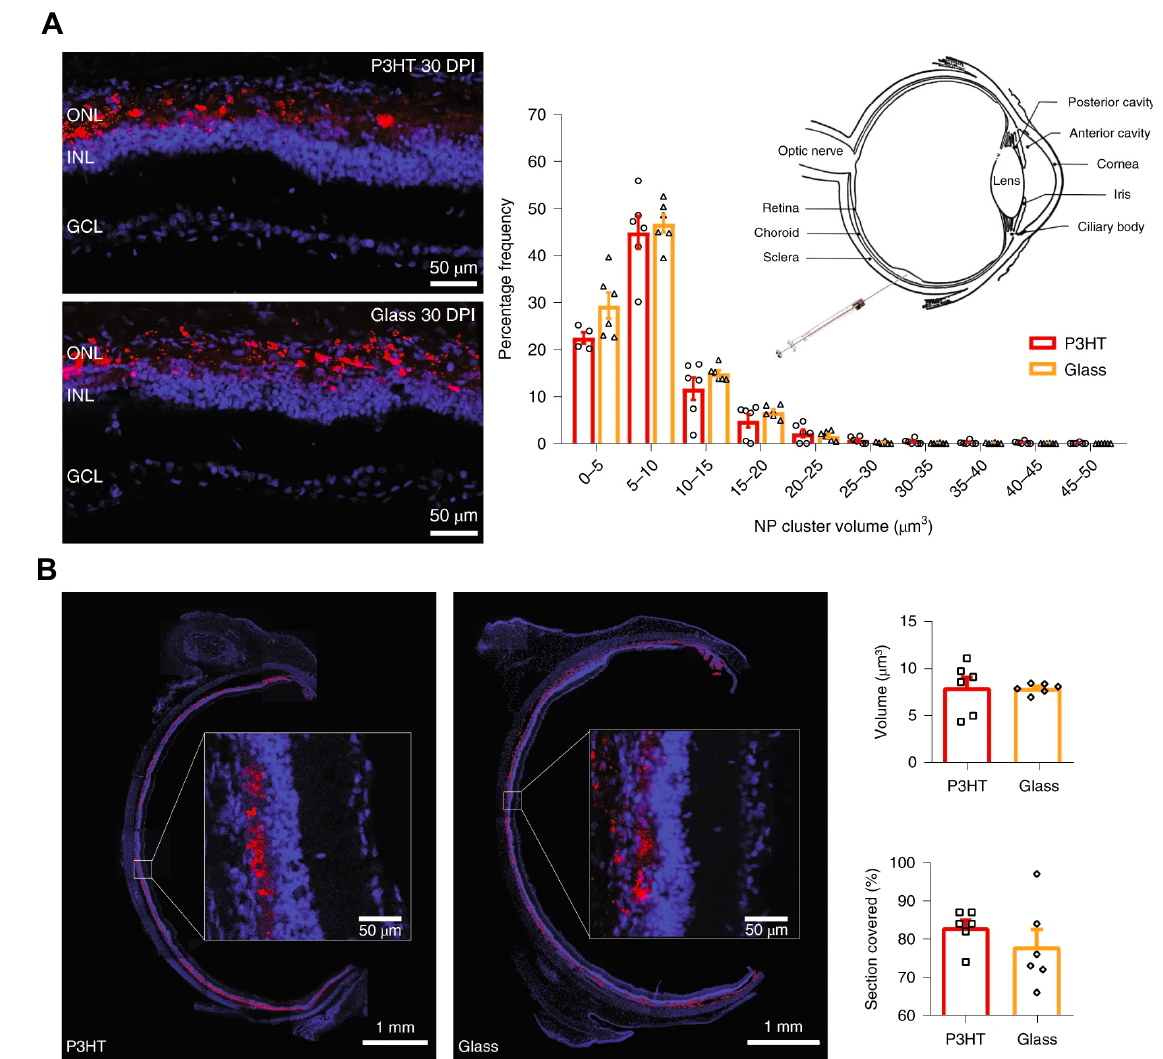
Figure 5. Wide and stable coverage of subretinally injected P3HT nanoparticles in the retina. ( A ) The Royal College of Surgeons (RCS) rats were injected with fluorescent glass nanoparticles or P3HT NPs at 30 DPI. The image shows the presence of NP fluorescence (red) with bisbenzimide nuclear staining (blue). Z -stack confocal retinal section images were used to estimate the percentage frequency distribution of the volume of NP clusters at 30 DPI. p > 0.10, two-sided Kolmogorov–Smirnov test. ( B ) A full equatorial reconstruction of RCS rat retinas injected with the indicated NPs at 30 DPI showed the NP (red) diffusion in the whole subretinal space, with no distribution or penetration in the internal retinal layers (insets at higher magnification). The bar graph shows the total NP volume in the subretinal space and the percentage coverage of retina by NPs at 30 DPI. p > 0.05, two-sided Mann–Whitney U -test. The bar graphs represent mean ± s.e.m.